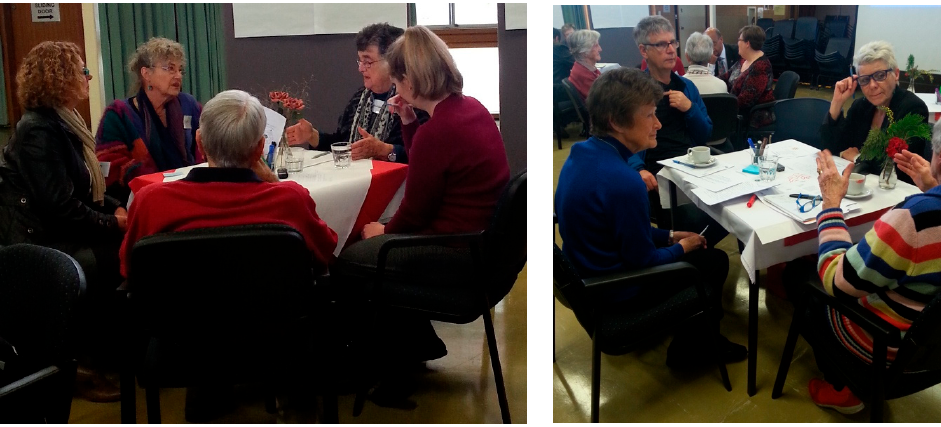
Figure 5. Unley residents at community consultation about age-friendliness. Table 2. Identified priority indicators of age friendly development at the City of Unley.